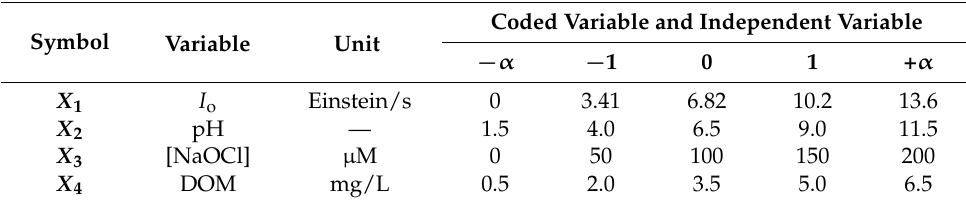
Table 1. Parameters of four